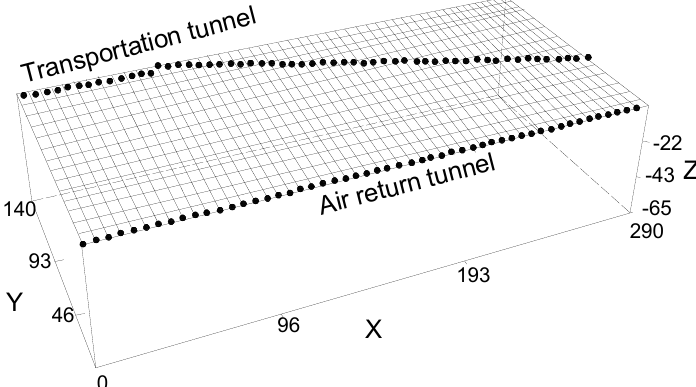
Figure 4. 3D mesh generation and electrode distribution.